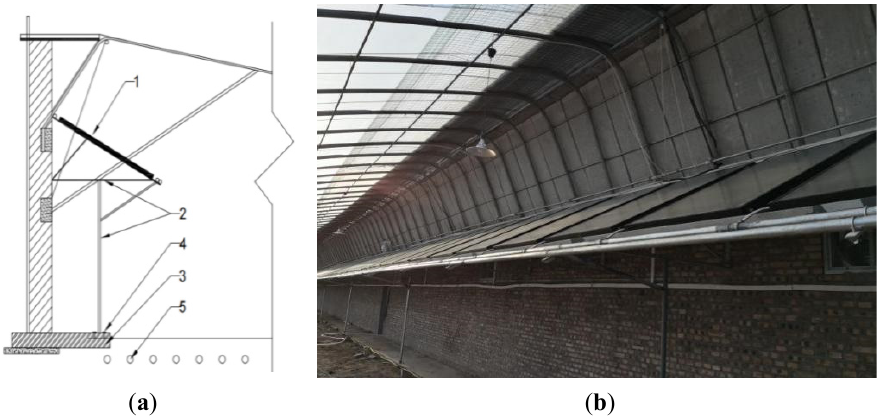
Figure 3. Installation of the solar collector. ( a ) Sectional view of the solar collector and ( b ) on-site installation of the solar collector. (1. solar collector, 2. support structure, 3. ground beam, 4. expansion bolt, 5. buried pipes.).